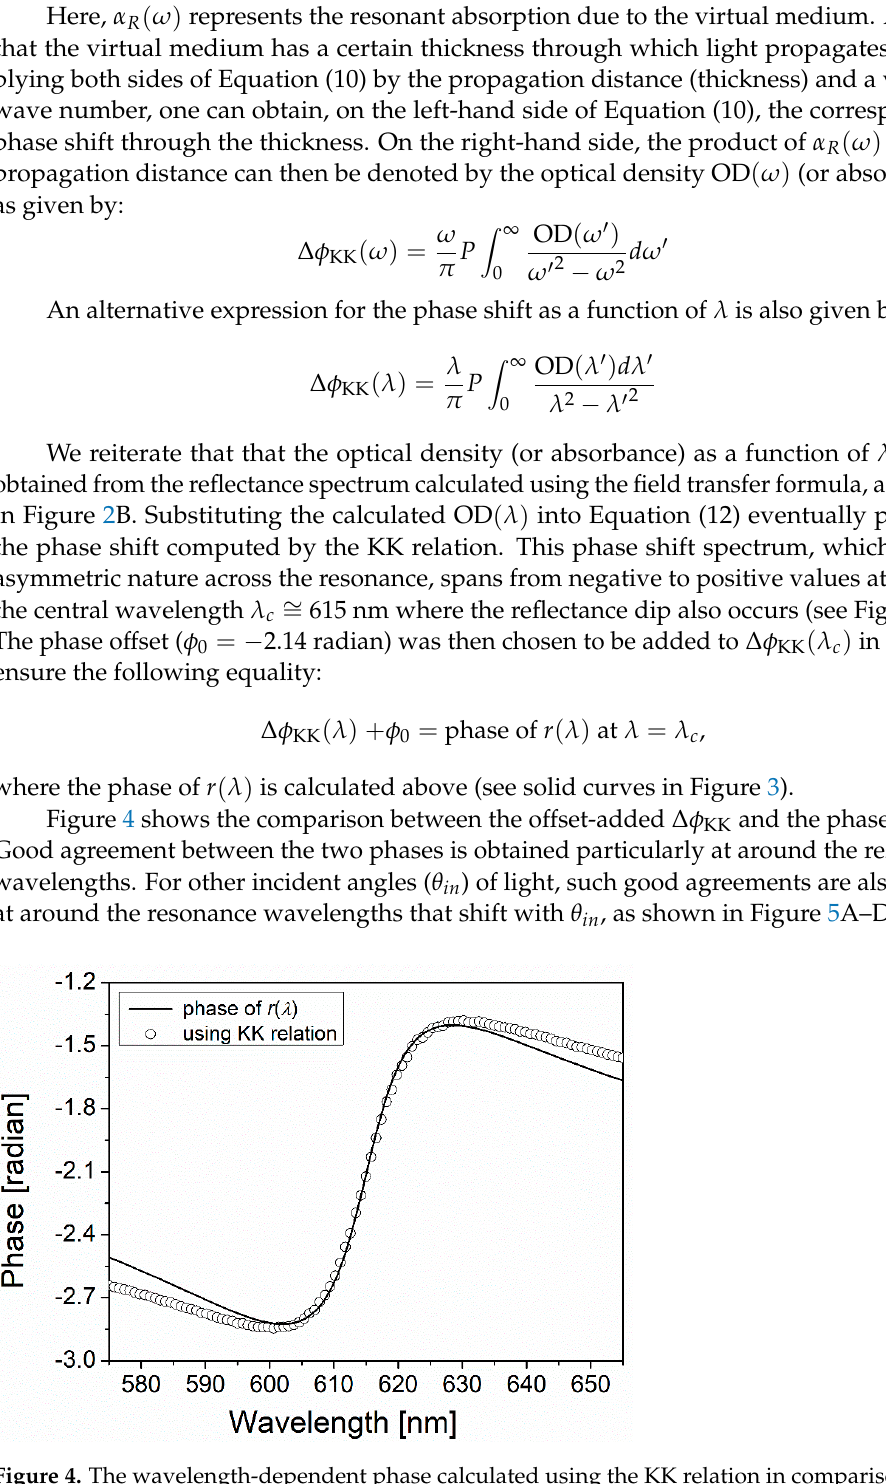
Figure 5. At other incident angles ( (cid:2016) (cid:3036)(cid:3041) ) of light, the phase calculated using the KK relation (empty circles) in comparison to the phase directly obtained from (cid:1870)((cid:2019)) calculated from a field transfer ma- trix formula Equation (1) (solid curves). The phase offsets used are (cid:2038) (cid:2868) = −2.28,−2.20,−2.06,−2.00 radians for ( A – D ), respectively. It is known that, in general, a wavelength-independent phase shift that can model the phase offset can occur during light propagation through a transparent medium (off an absorption resonance). This fact leads one to model the SPP excitation system by two ad- jacent virtual layers comprised of a resonantly absorptive layer and a transparent layer. The former layer derives the wavelength dependence of a phase shift (refractive index) from the resonant absorption, while the latter derives the wavelength-independent (cid:2038) (cid:2868) from its transparence. At around resonant wavelengths, the analogy of optical dispersion between trans- mitted light through an absorptive medium and reflected light from an SPP-generating interface can also be understood by the wavelength dependence of a certain degree of